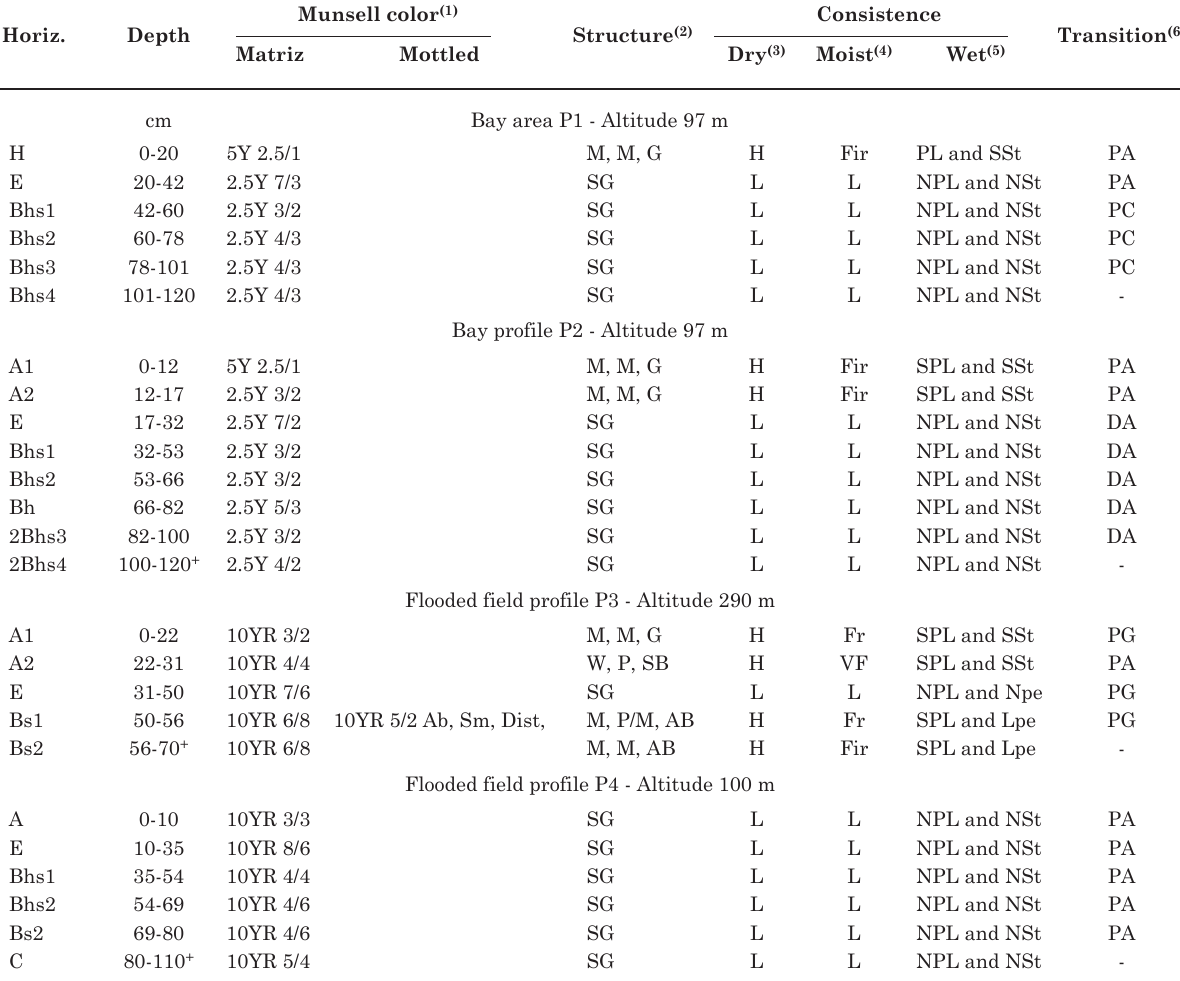
table 1. Morphological properties of soils developed from sediments of the river taquari watershed in the Pantanal of Mato grosso do sul